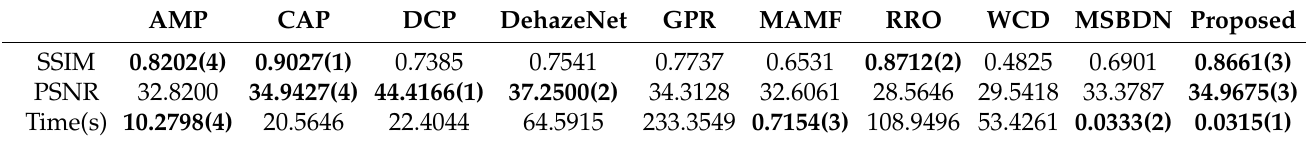
Table 3. Analysis of the defogging performance of the synthetic foggy images from HazeRD dataset using three evaluation indicators. The top four results are marked in bold, and the corresponding rankings are shown in parentheses. The higher SSIM and PSNR values are